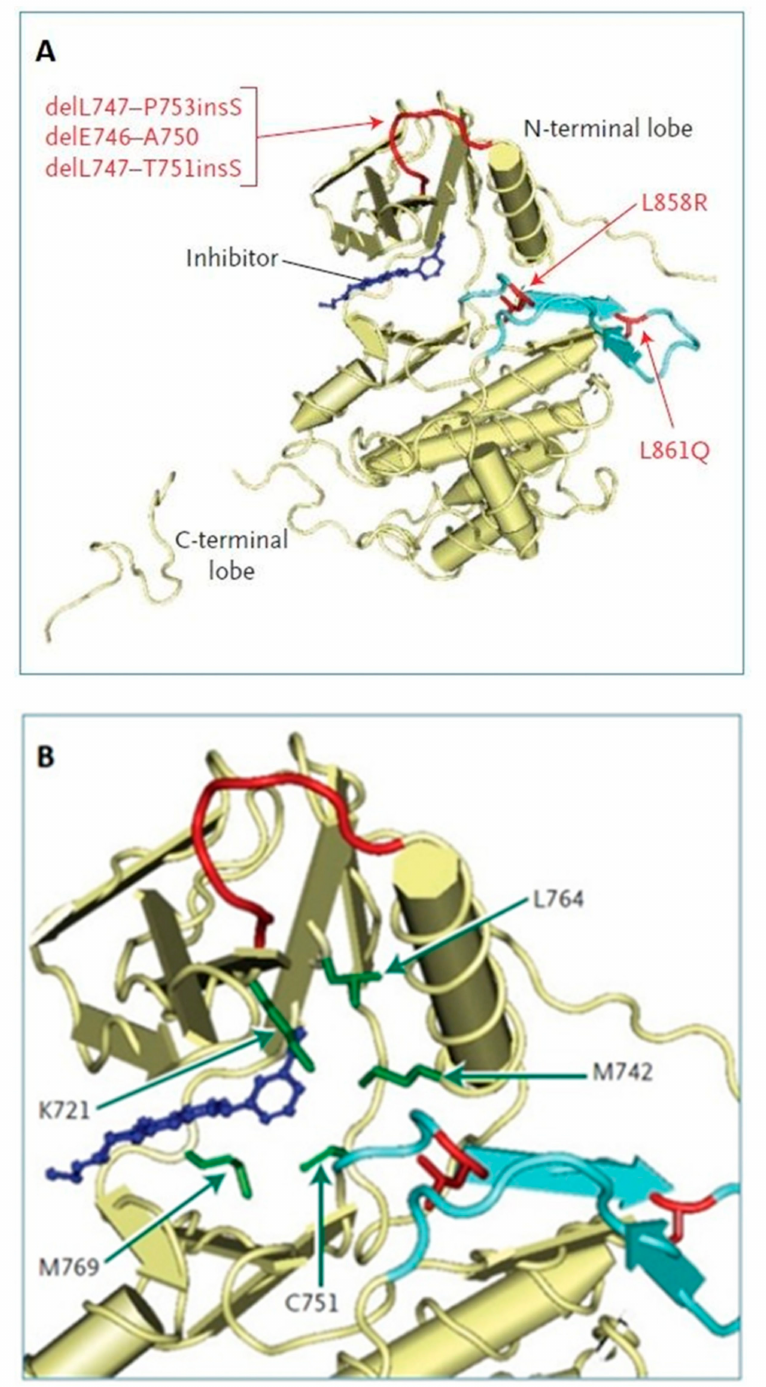
Figure 3. ( A , B ) Clustering of mutations in the Epidermal Growth Factor Receptor (EGFR) gene (adapted from Lynch T.J. et al., The New England Journal of Medicine, 2004) [23]. Gain-of-function mutations [32] in the tyrosine kinase domain of the EGFR gene markedly increase the sensitivity to EGFR tyrosine kinase inhibitors (TKIs) [33]. It